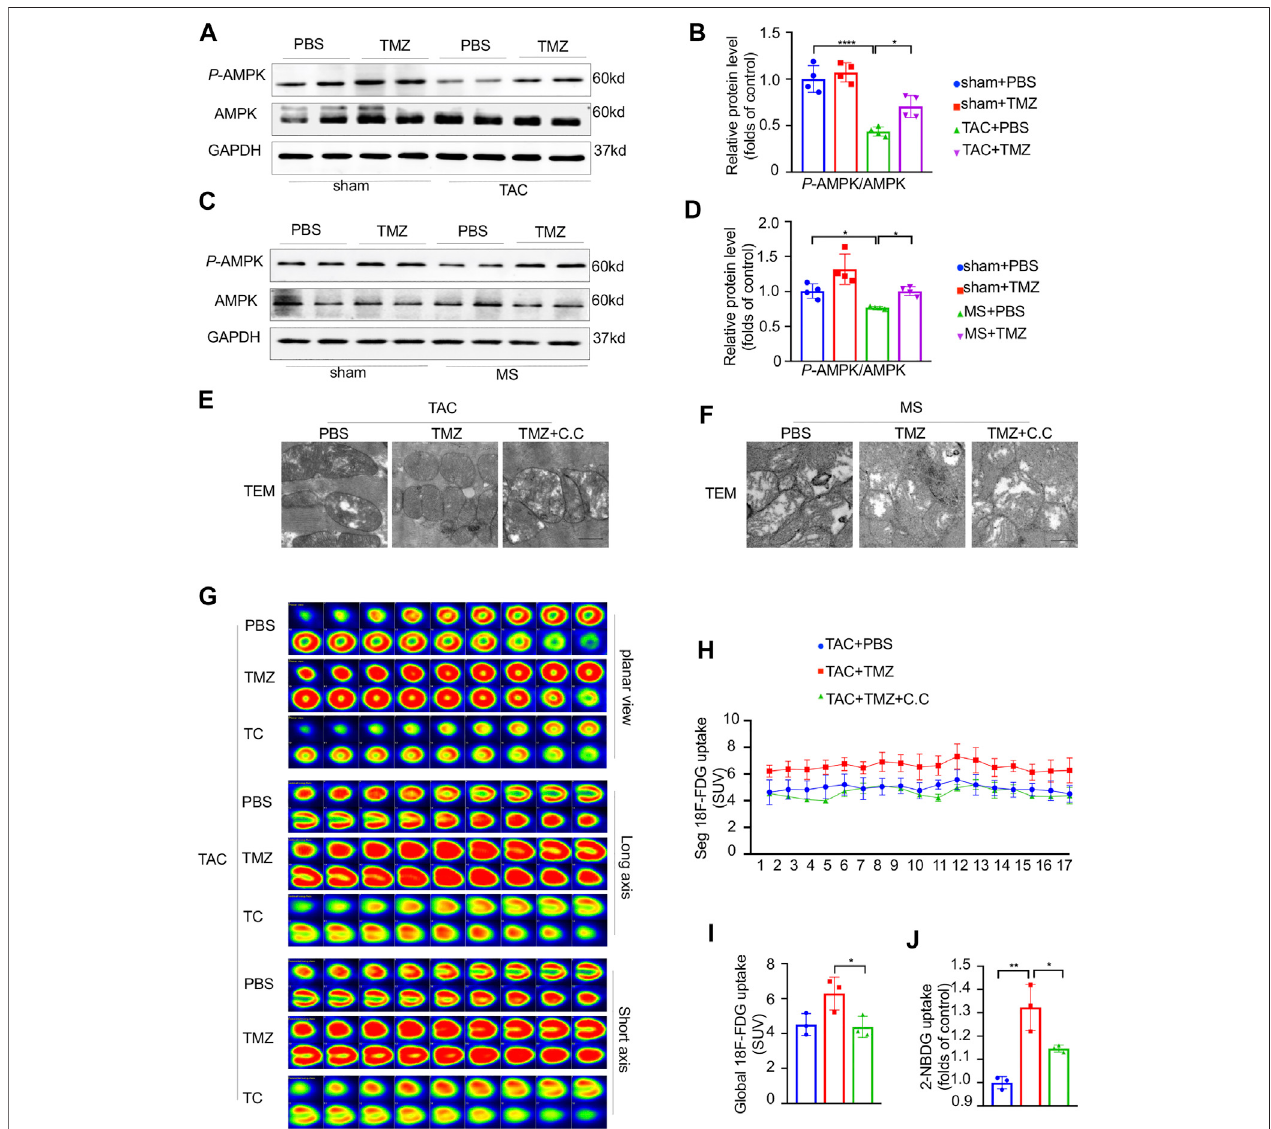
FIGURE 6 | AMPK was essential for the attenuation of pressure overload-induced mitochondria dysfunction, cardiac insulin resistance and heart failure by the treatment of trimetazidine. (A,B) Representative western blots in mice heart and correspondence quantitative analysis. (C,D) Representative western blots in NRCMs and correspondence quantitative analysis. (E,F) Representative TEM of mice hearts and NRCM in indicated groups. Scale bar (cid:2) 0.5 um. (G) The representative PET showing the cardiac glucose uptake and the quantitative analysis (H,I) , n (cid:2) 3. (J) Glucose uptake rate of isolated adult cardiomyocytes by 2-NBDG uptake assay, n (cid:2) 3. Graphical data are shown as mean ± SEM. Two-way ANOVA was used for analysis. * p < 0.05, ** p < 0.01, **** p < 0.0001, vs indicated group. TAC, Transverse aortic constriction; MS, Mechanical stretch; C.C., Compound C; SUV, Standard uptake value.